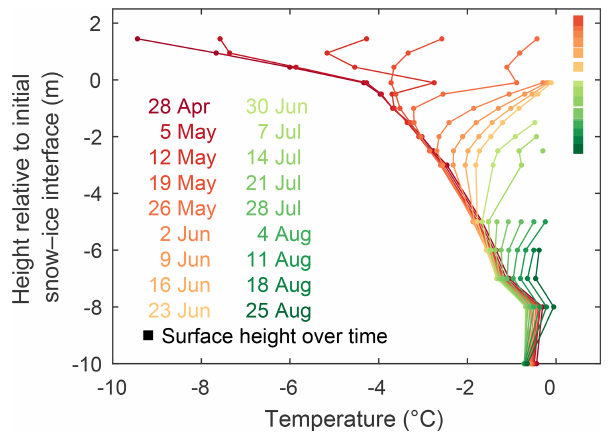
Figure 6. Vertical profiles of temperature in the upper 10m of the glacier at the On-Ice station in summer of 2013. After a sensor ex- ceeds 0 ◦ C, we do not plot the remaining